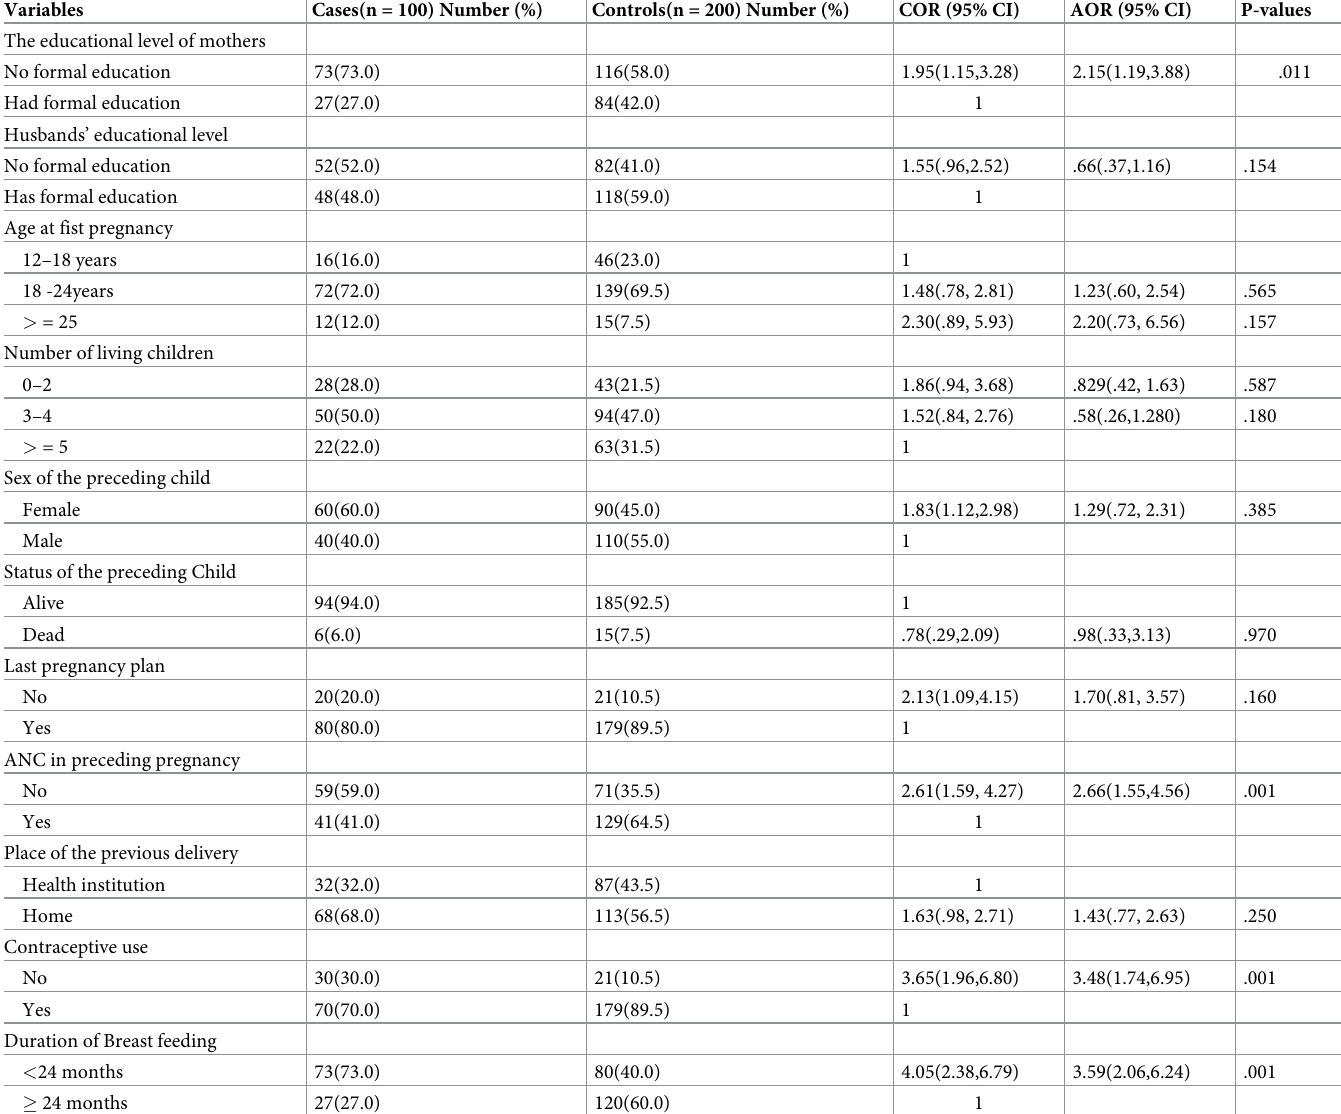
Table 3. Bivariate and multivariable analysis of determinant factors among reproductive-age women in Farta Woreda, South Gondar Zone, North West, Ethiopia,